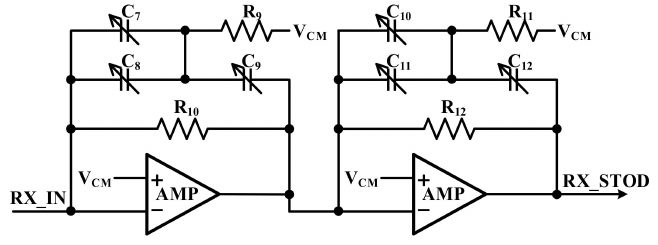
Figure 18. Block diagram of the high-pass filter.